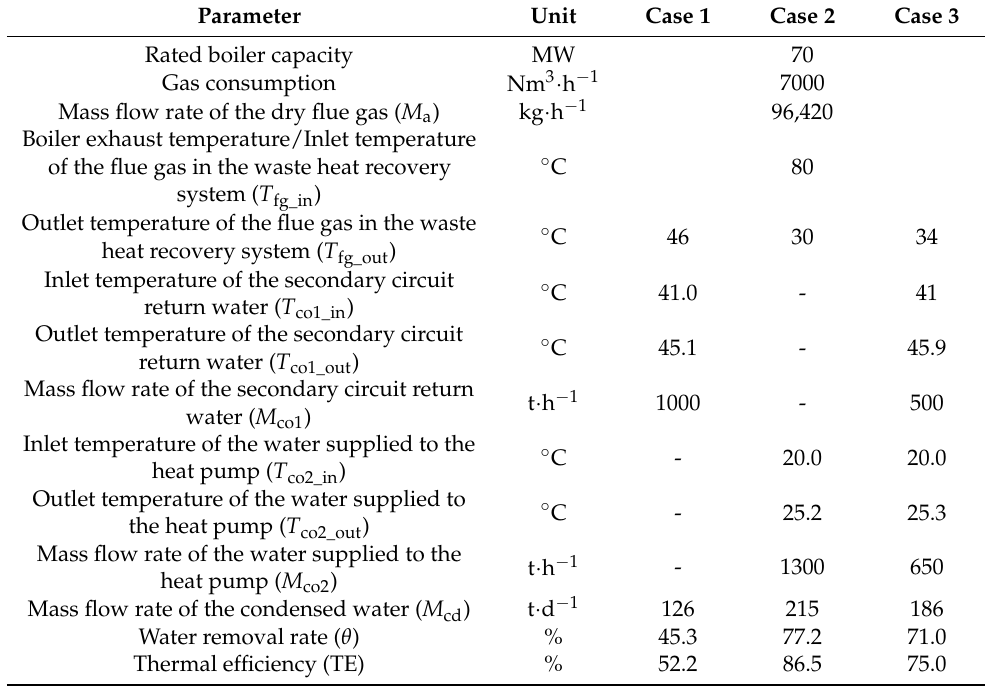
Table 2. System design parameters of the three projects